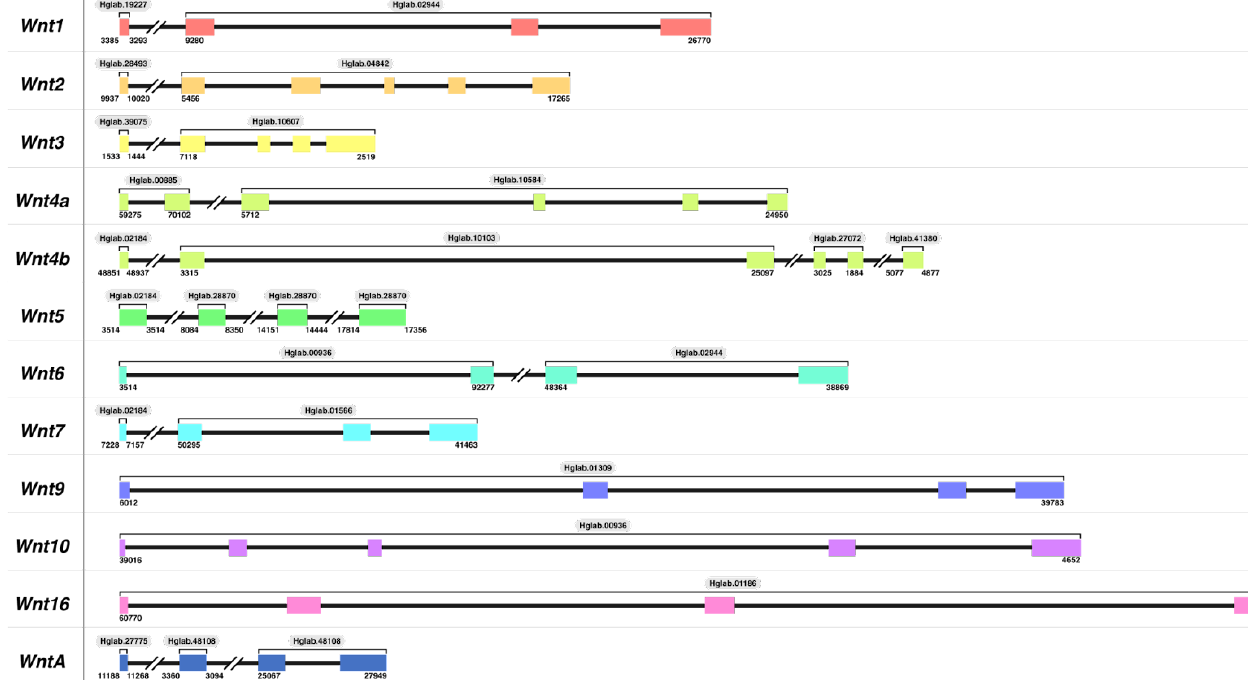
Figure 2. Structure of annotated Wnt family genes in H. glaberrima . The structure for all Wnt genes was characterized utilizing Wnt transcripts identified in the sea cucumber transcriptome data. All the scaffolds that contain each Wnt exon are identified by labels on top of each bracket (e.g., Hglab.02944). The start and end coordinates of the Wnt s span across each scaffold are shown at the bottom of each gene structure based on the genome nucleotide sequences (NCBI ID: GCA_009936505.2). Broken lines between exons represent a gene structure break due to genome fragmentation. Exon and intron sizes are based on base pair lengths, in which each base pair is equal to 0.2 for exons and 0.05 for